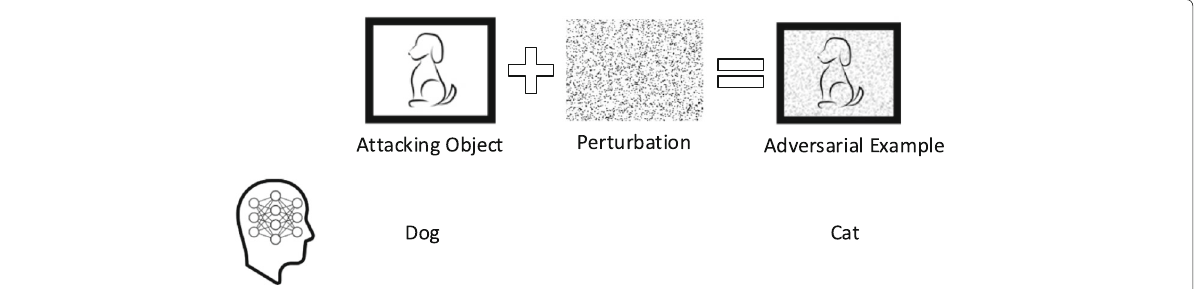
Fig. 1 Adversarial example illustration